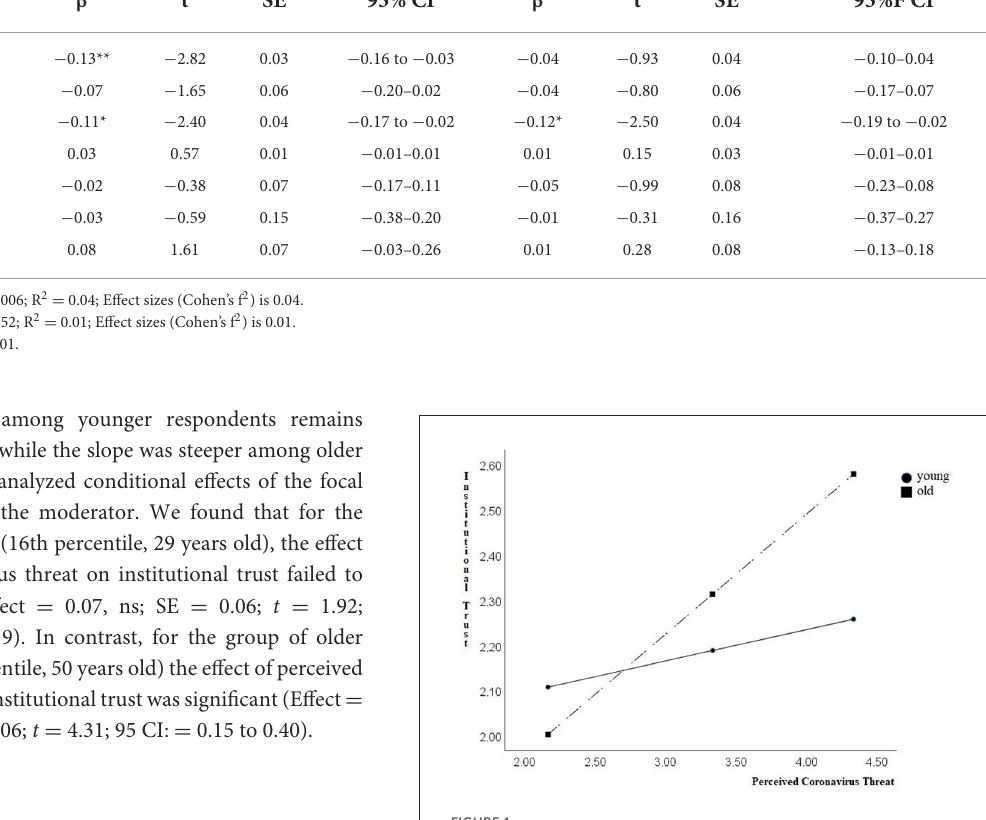
FIGURE1 Graphical depiction of the interaction effect between perceived coronavirus threat (X) and age for institutional trust (Y) ( N =